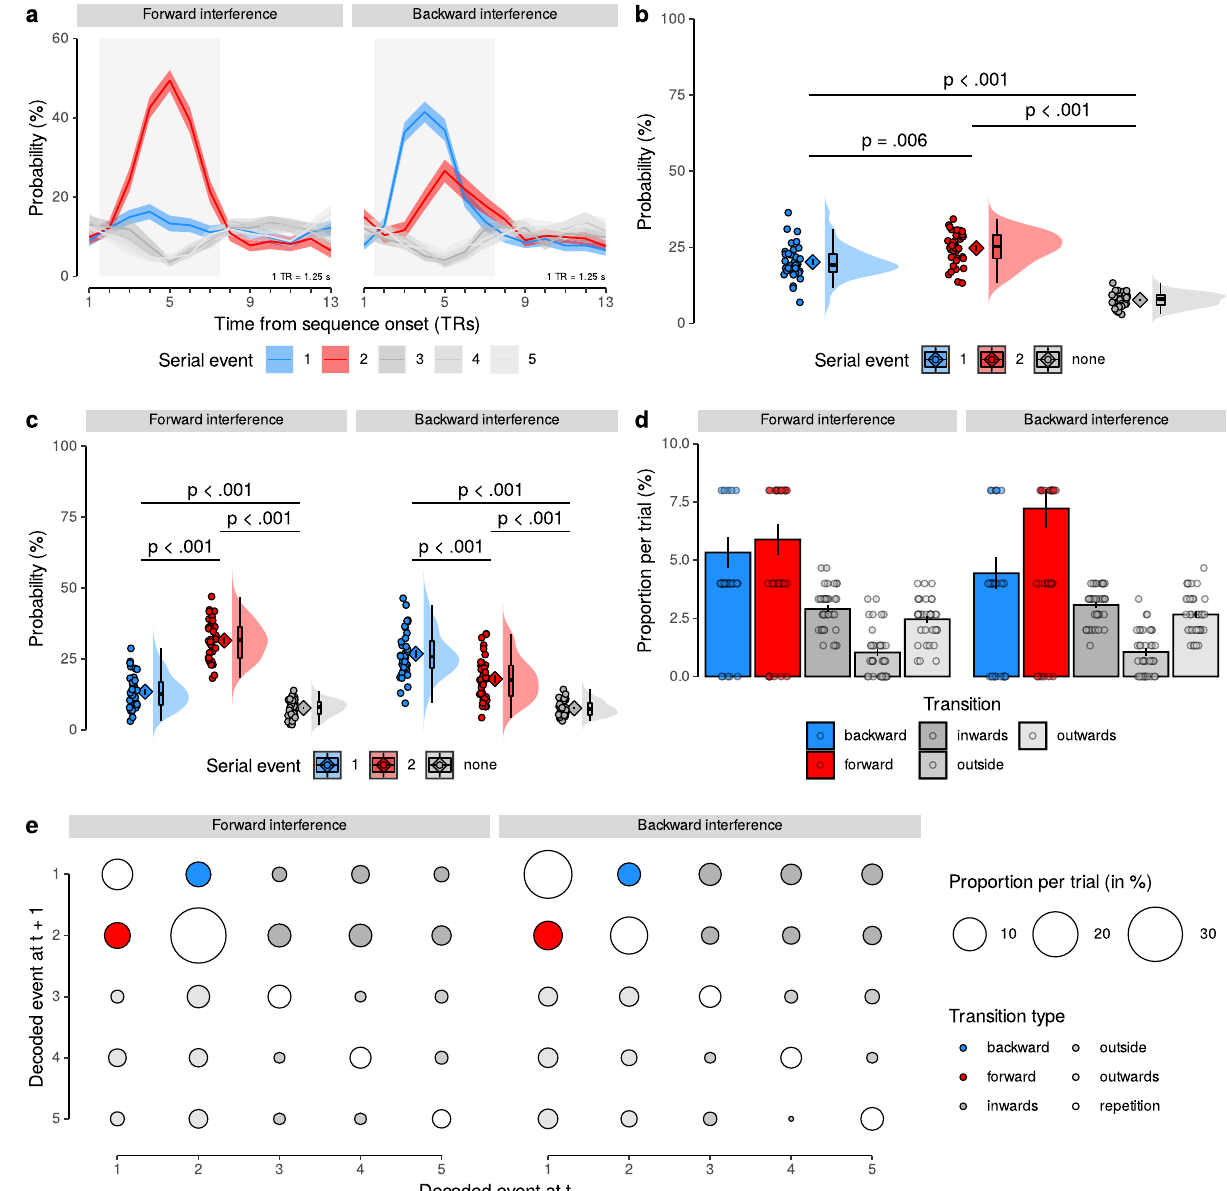
Fig. 4 Ordering of two-item sequences on repetition trials. a Time courses (in TRs from sequence onset) of probabilistic classi fi er evidence (in %) in repetition trials, color-coded by event type ( fi rst, second and the three remaining non-sequence items, see legend). Data shown separately for forward (left) and backward (right) interference conditions. Gray background indicates relevant time period independently inferred from response functions (Fig. 2d). Shaded areas represent ±1 SEM. 1 TR = 1.25 s. b Mean probability of event types averaged across all TRs in the relevant time period, as in (a). Each dot represents one participant, the probability density of the data is shown as rain cloud plots (cf. 141 ). Boxplots indicate the median and interquartile range (IQR, i.e., distance between the fi rst and third quartiles). The lower and upper hinges correspond to the fi rst and third quartiles (the 25th and 75th percentiles). The upper whisker extends from the hinge to the largest value no further than 1.5* IQR from the hinge. The lower whisker extends from the hinge to the smallest value at most 1.5* IQR of the hinge. The diamond shapes show the sample mean and error bars indicate ±1 SEM ( N = 36, t s ≥ 3.31, p s ≤ 0.006, LME model with post hoc Tukey ’ s honest signi fi cant difference (HSD) tests). c Average probability of event types, separately for forward/backward conditions as in (a), plots as in (b) ( N = 36, t s ≥ 4.14, p s < 0.001, LME model with post hoc Tukey ’ s HSD tests). d Mean trial-wise proportion of each transition type, separately for forward/backward conditions, as in (a) ( N = 36, t s ≥ 4.64, p s < 0.001, four two-sided paired t -tests, Bonferroni-corrected). e Transition matrix of decoded images indicating mean proportions per trial, separately for forward/backward conditions, as in (a). Transition types highlighted in colors (see legend). All statistics have been derived from data of N = 36 human participants who participated in one experiment. Source data are provided as a Source Data fi item shown only once was easier to detect when it followed a probability than the single fi rst event (31.55% vs. 13.50%, p < sustained activation of a different pattern, compared to when it 0.001). In the backward interference condition, the repeated fi rst preceded an interfering activation (Fig. 4c). We found no main event had only 9% higher probability than the single second event effect of repetition, p = 0.91 (Fig. 4c). (26.87% vs. 18.00%, p < 0.001, corrected). This means that the